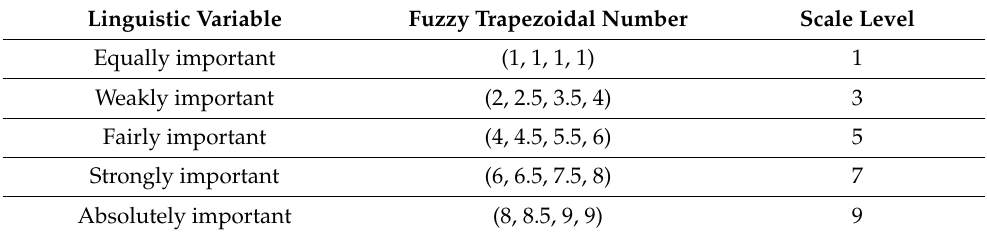
Table 5. Fuzzy numbers for five linguistic scales.